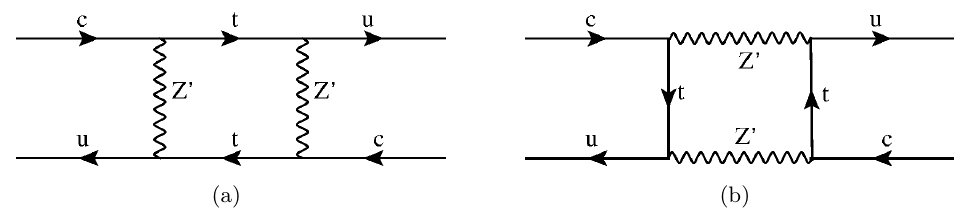
Figure 16 . One-loop box Feynman diagrams contributing to D 0 − D 0 mixing due to a generic Z 0 with non-zero off-diagonal couplings to the top